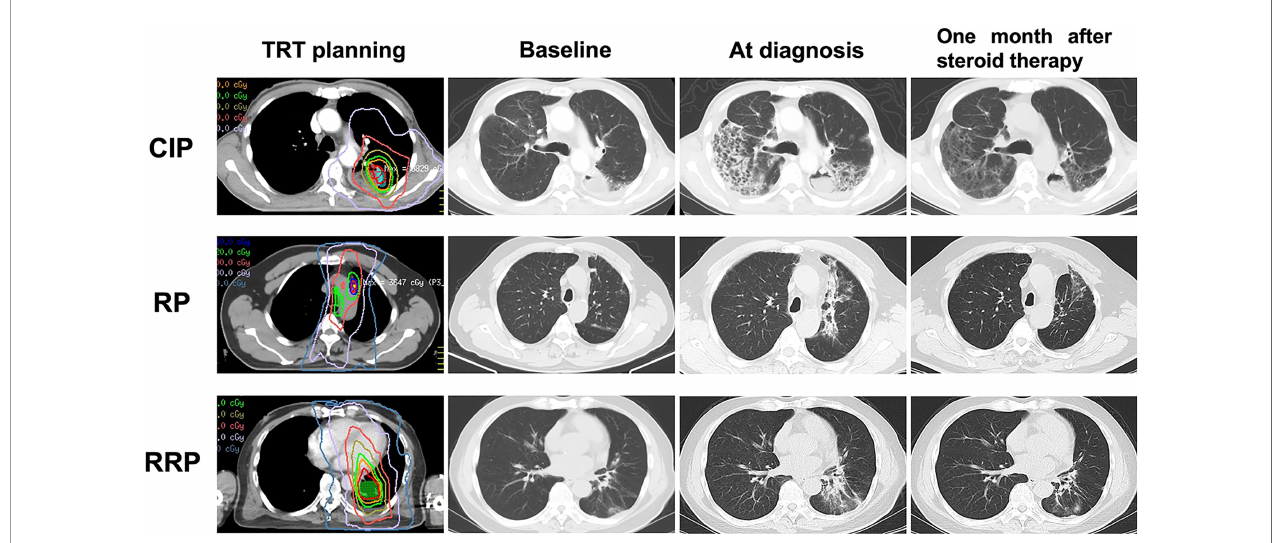
FIGURE 1 | Distinctive CT changes of CIP, RP and RRP at baseline, at diagnosis and one month after steroid therapy. CIP, checkpoint inhibitor pneumonitis; RP, radiation pneumonitis; RRP, radiation recall pneumonitis; TRT, thoracic